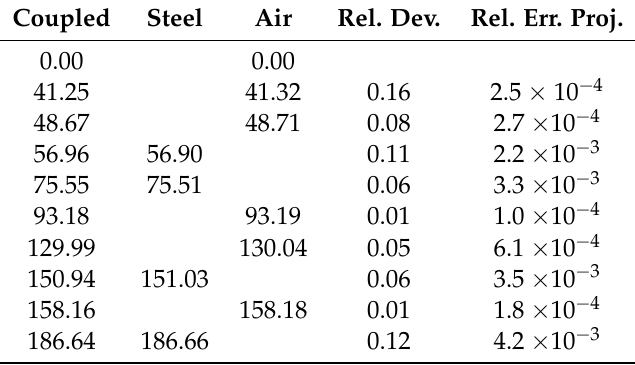
Table 1. Steel-air-structure.